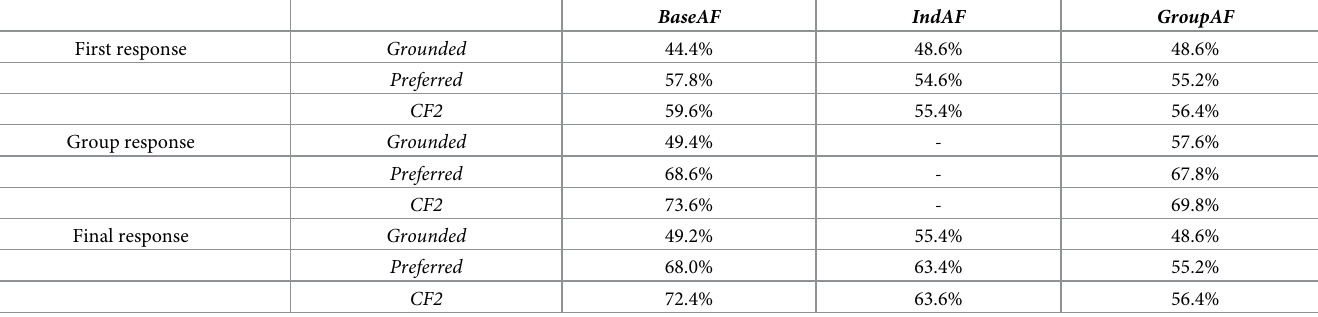
Table 2. Percentage of correct predictions of the three semantics ( grounded , preferred , and CF2 ) applied to the three AFs (BaseAF , IndAF , GroupAF) for the three responses provided in part